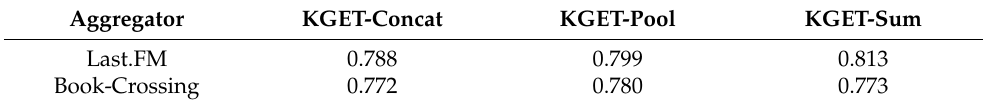
Table 9. The influence of aggregator in F1.